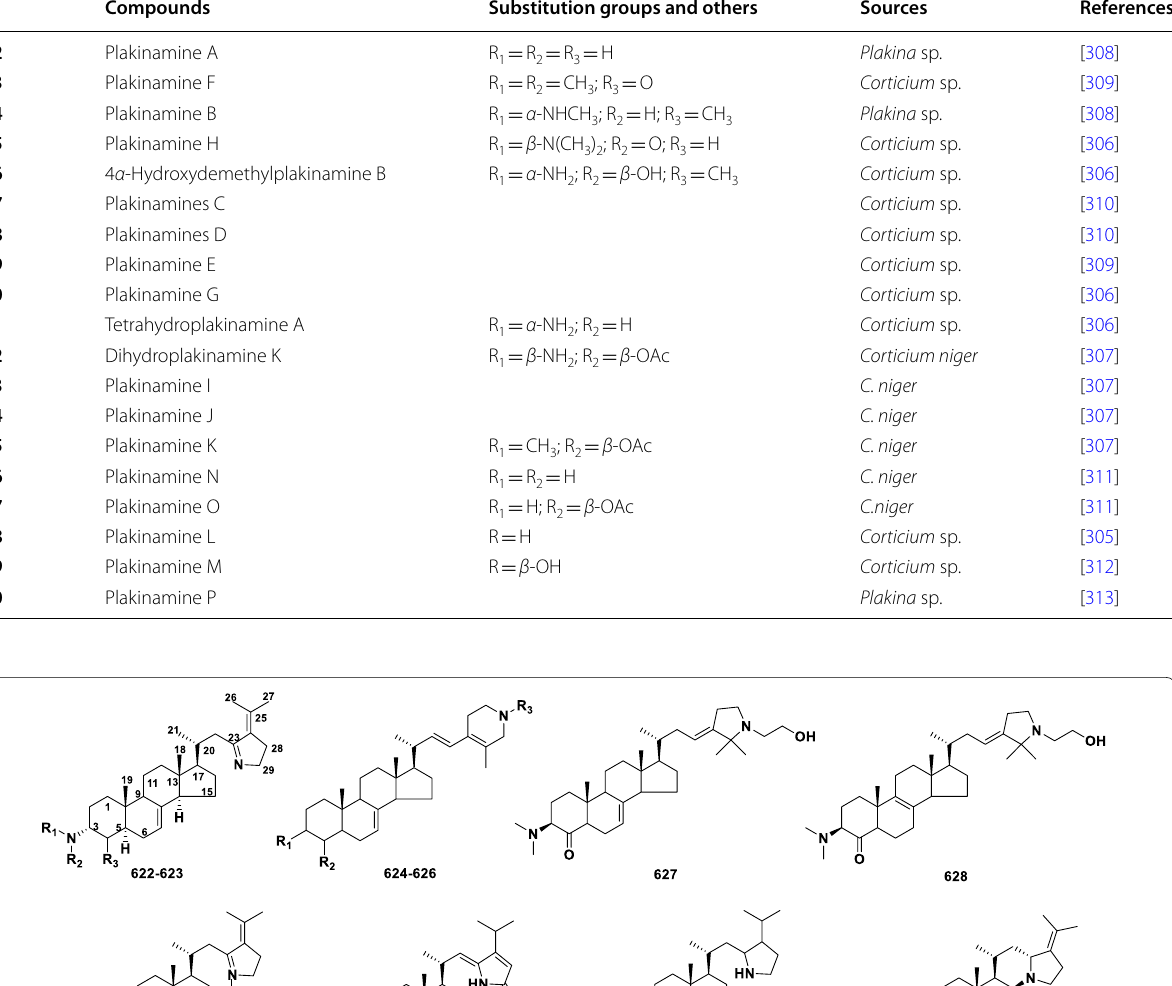
Table 14 Structures and sources of plakinamines 622–640